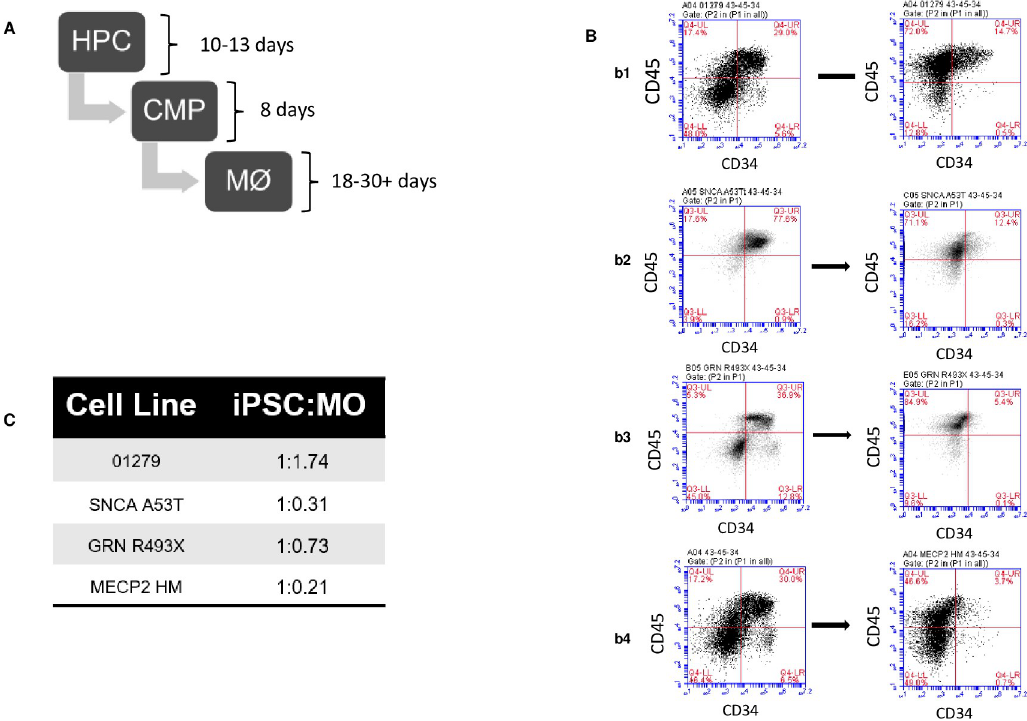
Fig 3. Generation and characterization of isogenic iPSCs for disease modelling. (A) Schematic representation of the differentiation process from HPC to common myeloid progenitor (CMP) to macrophages under defined conditions. (B) Loss of CD34 expression and augmentation of HPC and CMP stage of differentiation for (b1) 01279, (b2) SNCA A53T, (b3) GRN R493X, and (b4) MECP2 HM KO. (C) Efficiency of generating macrophage from iPSCs lines. The efficiency calculated by total viable cell number of iPSC seeded and total number viable macrophages obtained at the end of the